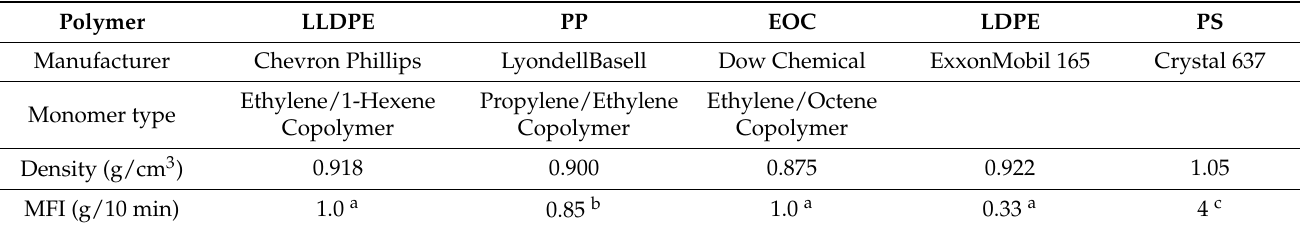
Table 1. Summary of the polymers used for the PE/PP and PE/PS systems. Polymer LLDPE